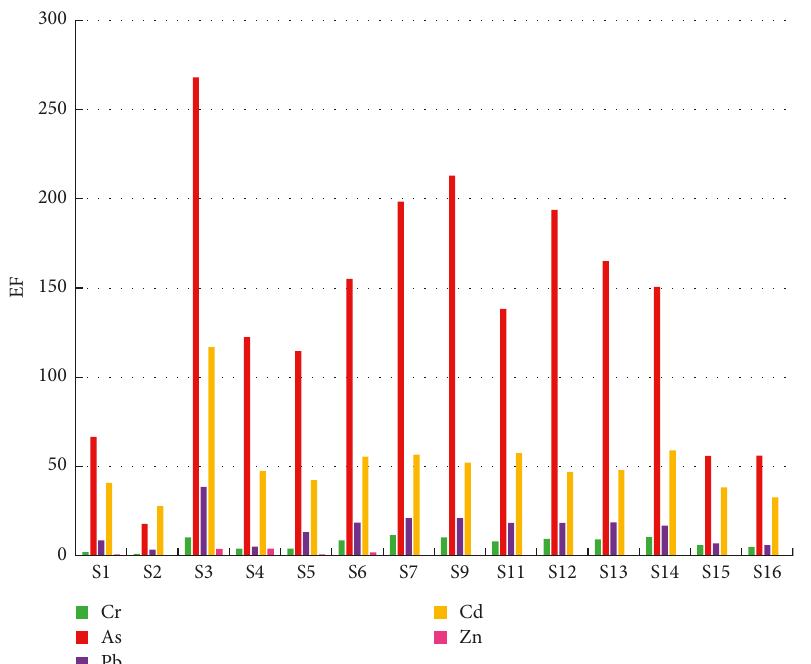
Figure 4: The column chart of the enrichment factor (EF) of heavy metals in